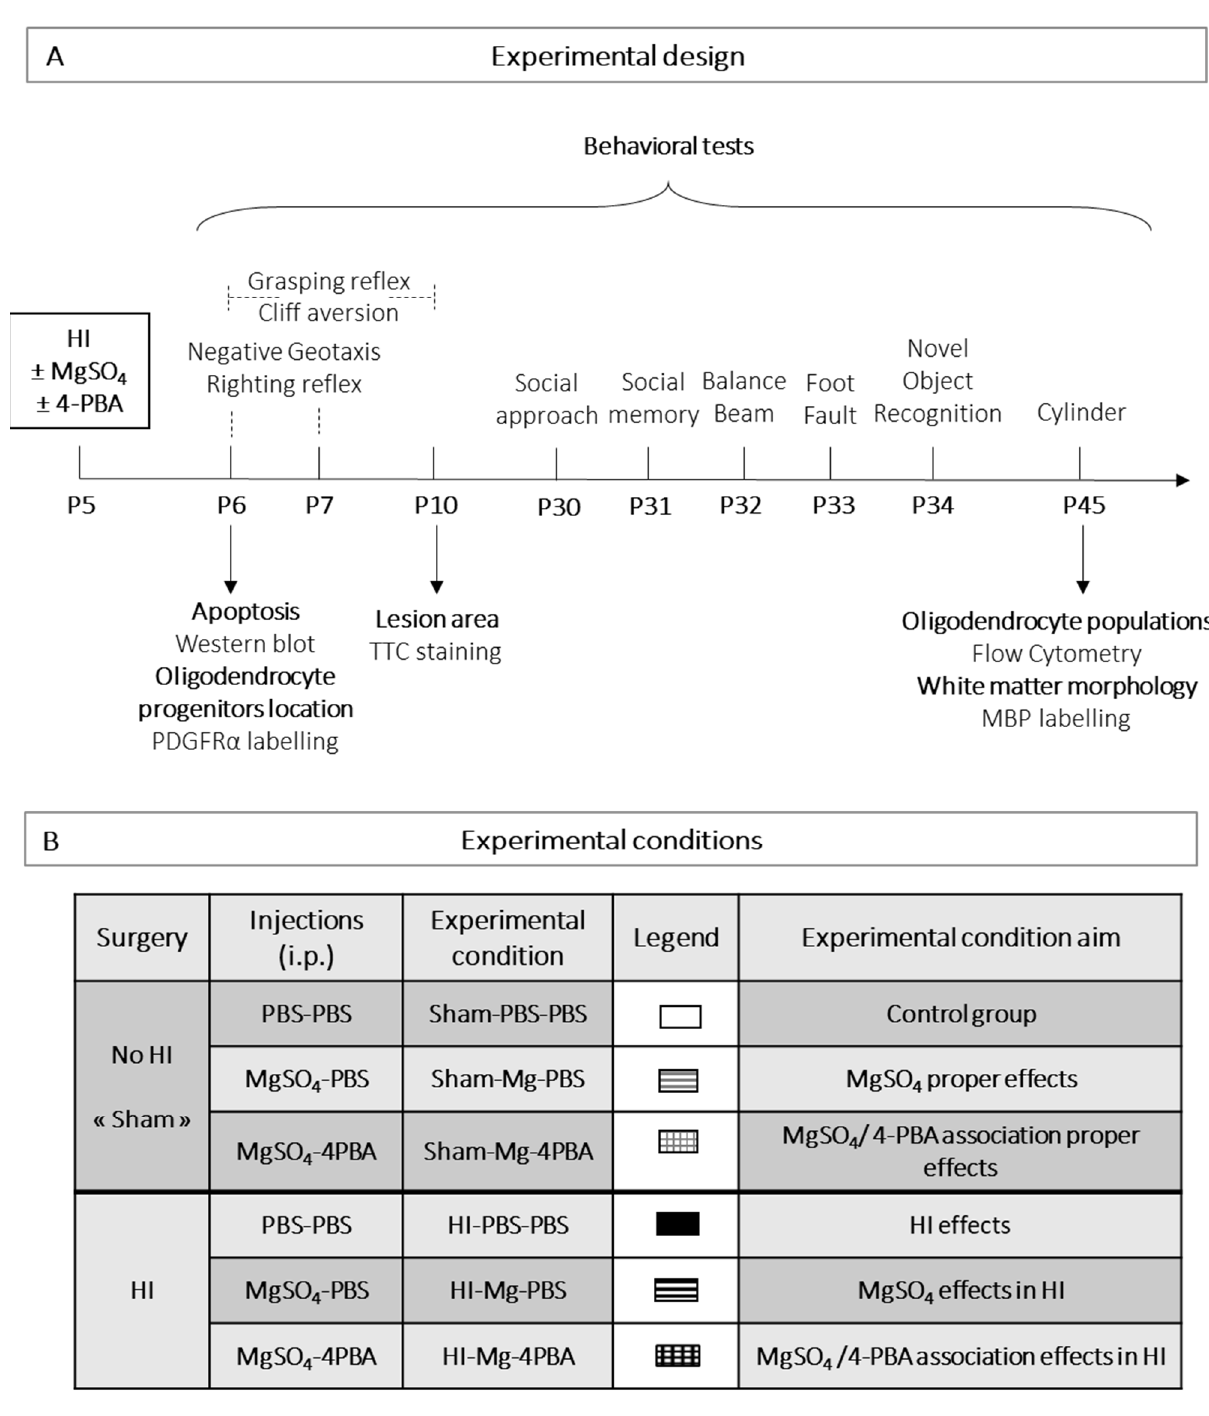
Figure 9. Experimental design of the study (A) and experimental conditions